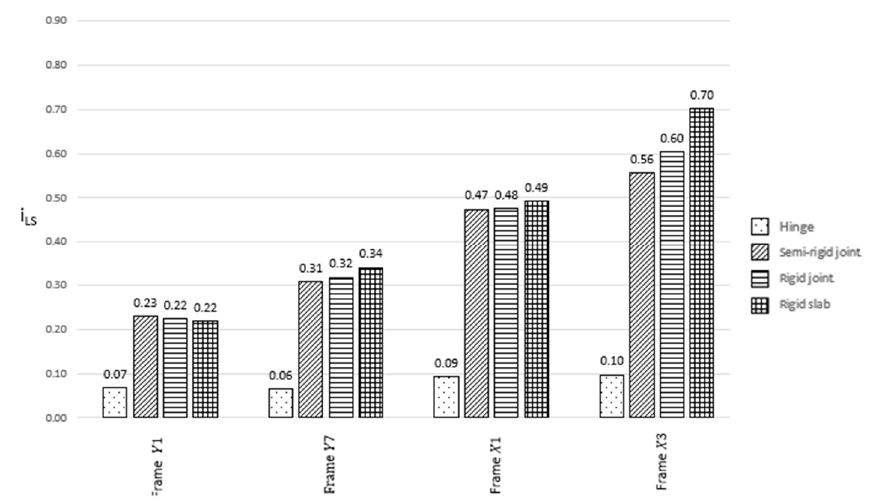
Figure 17. Seismic safety factors in terms of the return period.